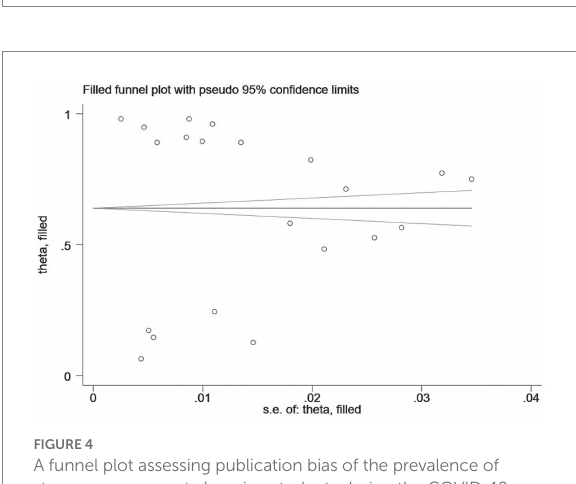
FIGURE 4 A funnel plot assessing publication bias of the prevalence of stress among remote learning students during the COVID-19 pandemic.